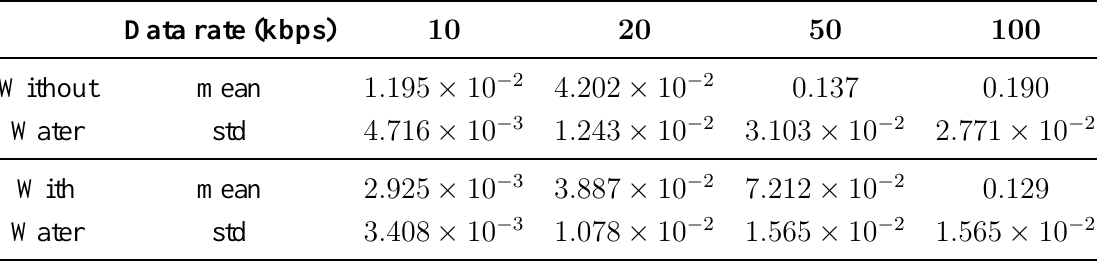
Table 3. Obtained bit error rate (BER) for stainless steel pipe